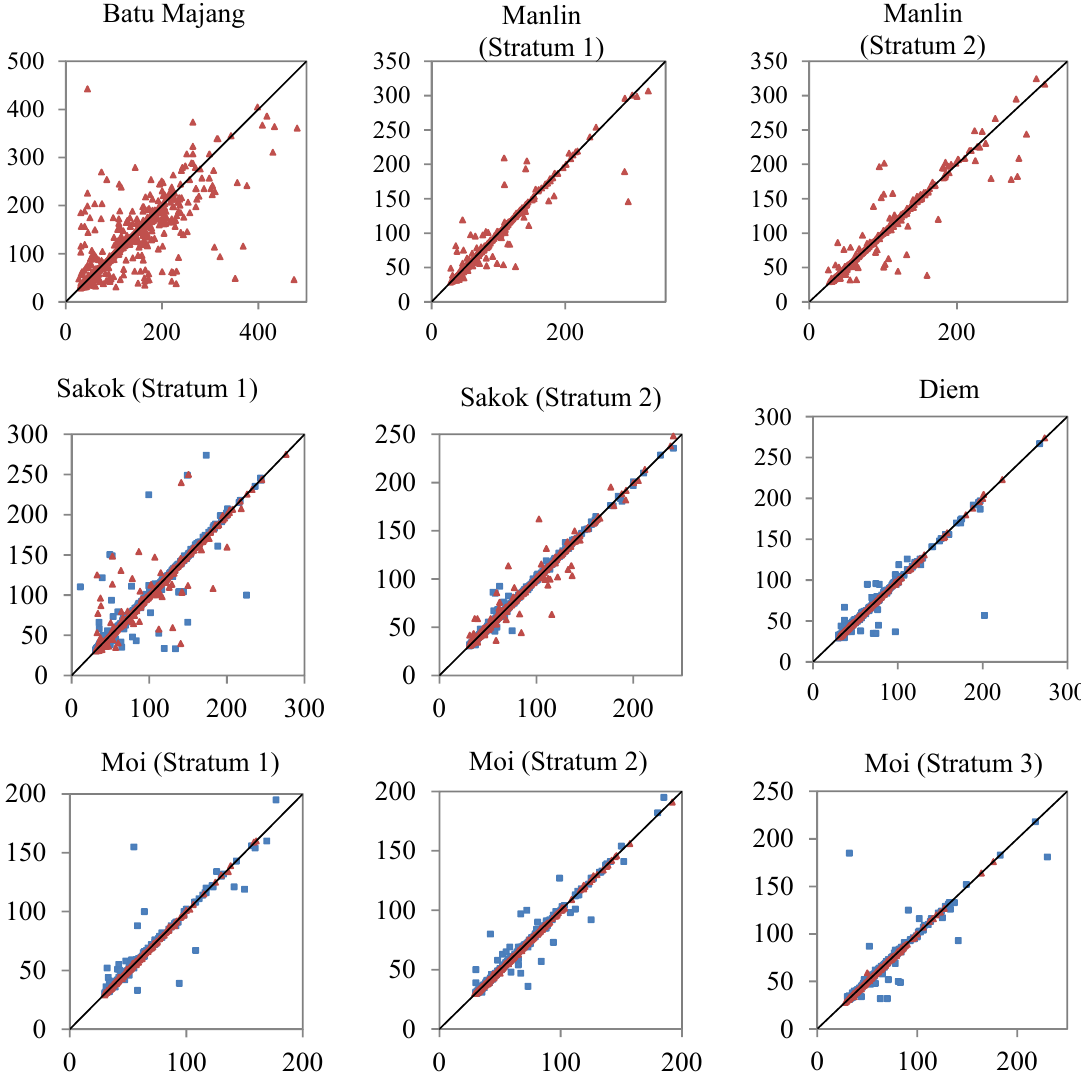
Figure 3. Relationship between the DBH of individual trees recorded by community members and foresters in year 1 (blue square) and year 2 (red triangle) (with same units on y -axis as on x -axis and y = x lines; n = 289 permanent plots); each point in the graphs represents one census of a single tree DBH as measured by foresters ( x -axis) and community members ( y -axis); Batu Majang and Manlin Strata 1–2 does not have any measurements from the first round of monitoring (blue square) as trees were not marked individually in year